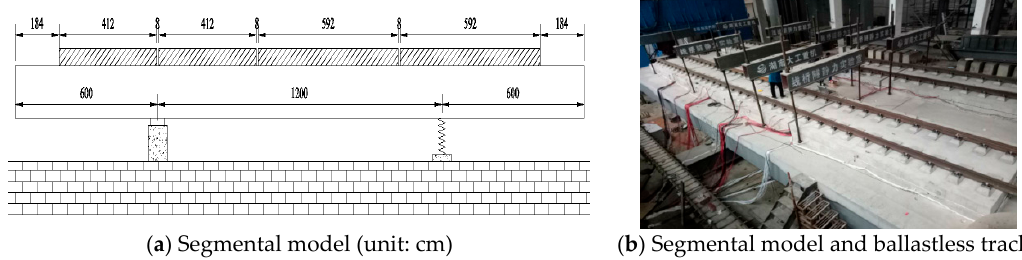
Figure 4. Segmental model of the Ganjiang Bridge: ( a ) model, ( b ) model and tracks.